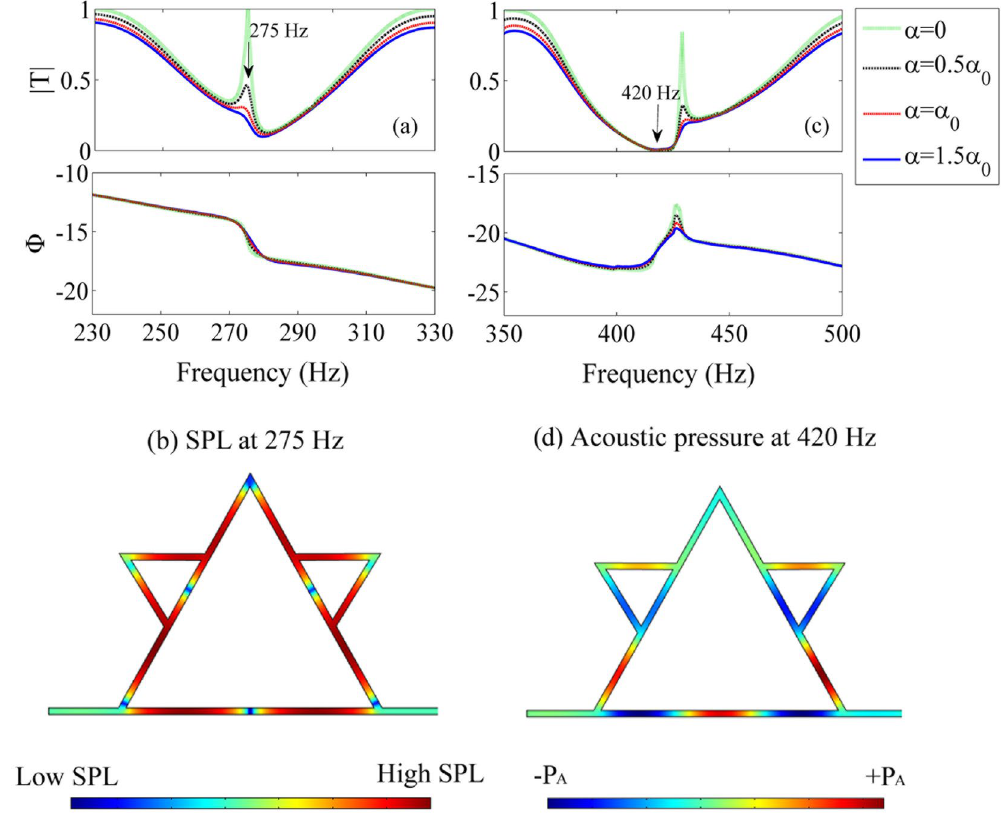
Figure 4. Transmissions and acoustic fields in the QKCM. ( a ) and ( c ) The theoretical transmissions calculated with Eq. (3) based on different attenuation coefficients in which f d 2 78 10 /0 5 of ( b ) SPL at 275 Hz and ( d ) acoustic pressure at 420 Hz simulated with COMSOL